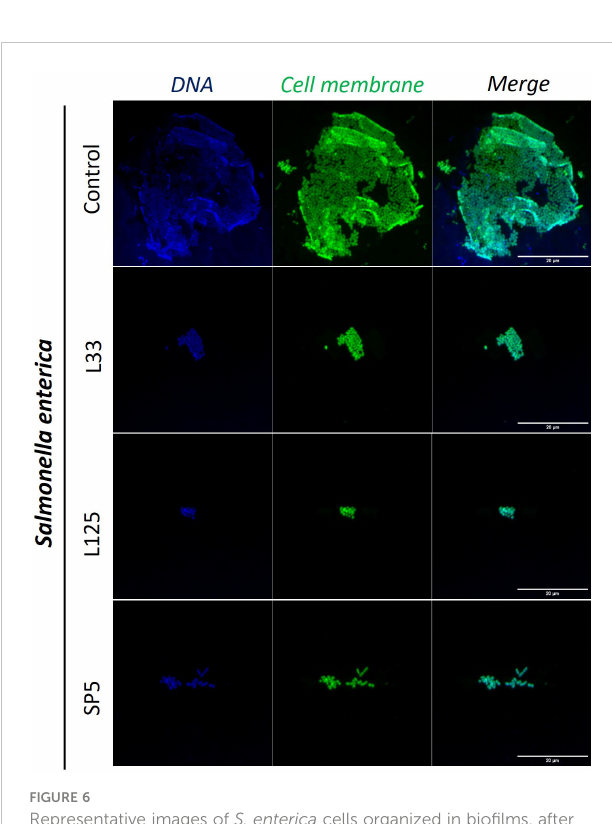
FIGURE 6 Representative images of S. enterica cells organized in bio fi lms, after 24 h incubation in TSB (control) or adjusted CFCS (50% v/v, pH 6.2) derived from Lp. pentosus L33, Lp. plantarum L125 or Lc. paracasei SP5. Pathogen cell membranes were stained with CFSE (green) and DNA with Hoechst 33342 (blue) (scale bar, 20 m m).